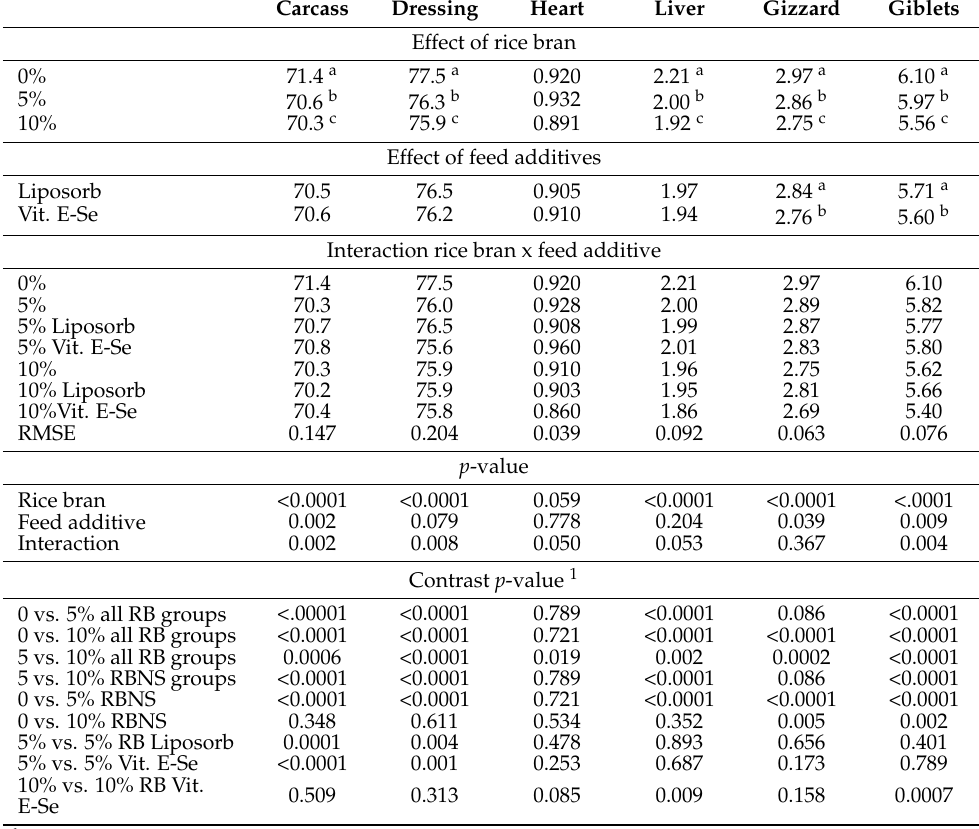
Table 4. Carcass traits and relative organs (%) of broiler chickens as affected by dietary rice bran treatments during the